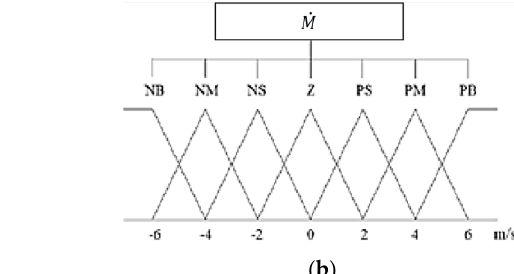
( b ) Figure 11. Membership functions of FLC-Output: ( a ) Language variable architecture of